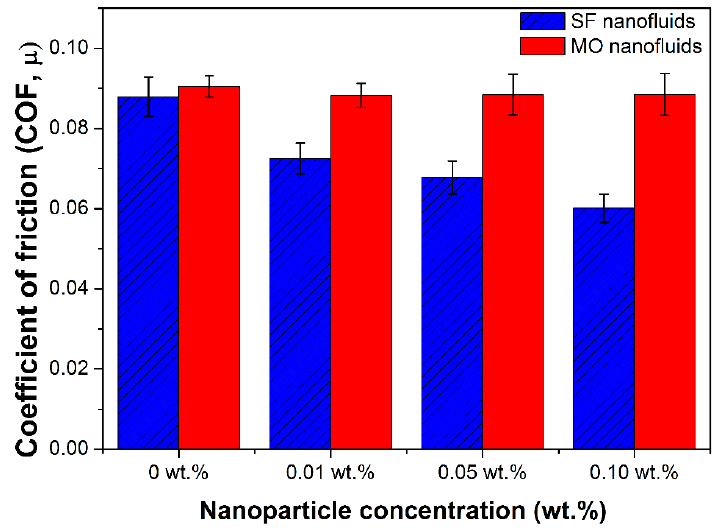
Figure 6. Coefficient of friction values for MO and SF nanofluids with varying HNT nanoparticle